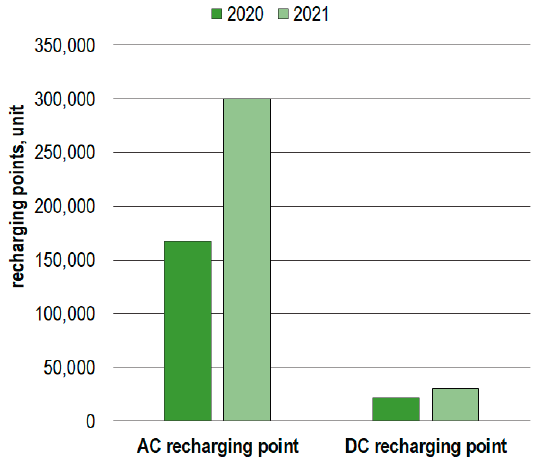
Figure 2. Public charging points by charging current.